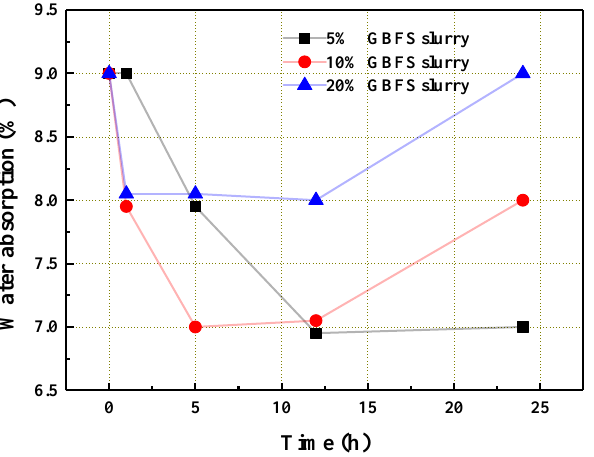
Figure 3. The water absorption of the coral aggregate that was treated with the GBFS slurry. Compared with the untreated coral aggregate with the polyporous and non-compacted structure pictured in Figure 4a, the aggregate that was treated with GBFS became dense and compacted, as shown in Figure 4b. Most large pores observed in Figure 4a were filled up by the GBFS slurry [30].